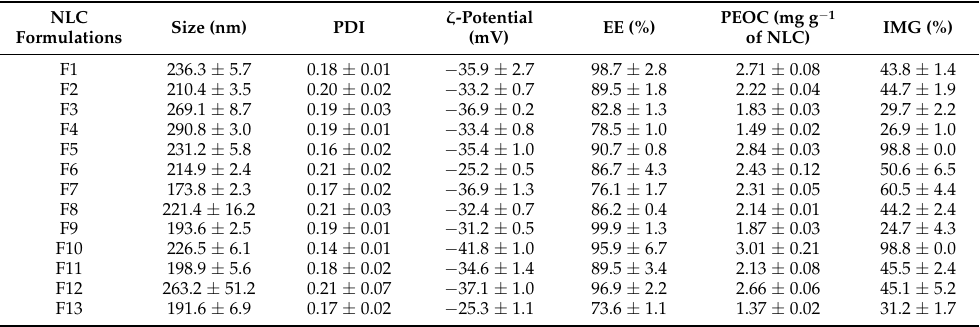
Table 2. Size, polydispersity index (PDI), zeta potential ( ζ -potential), entrapment efficiency (EE), PEO content (PEOC), and inhibition of mycelial growth (IMG) of NLC formulations containing palmarosa essential oil prepared according to the mixture design.